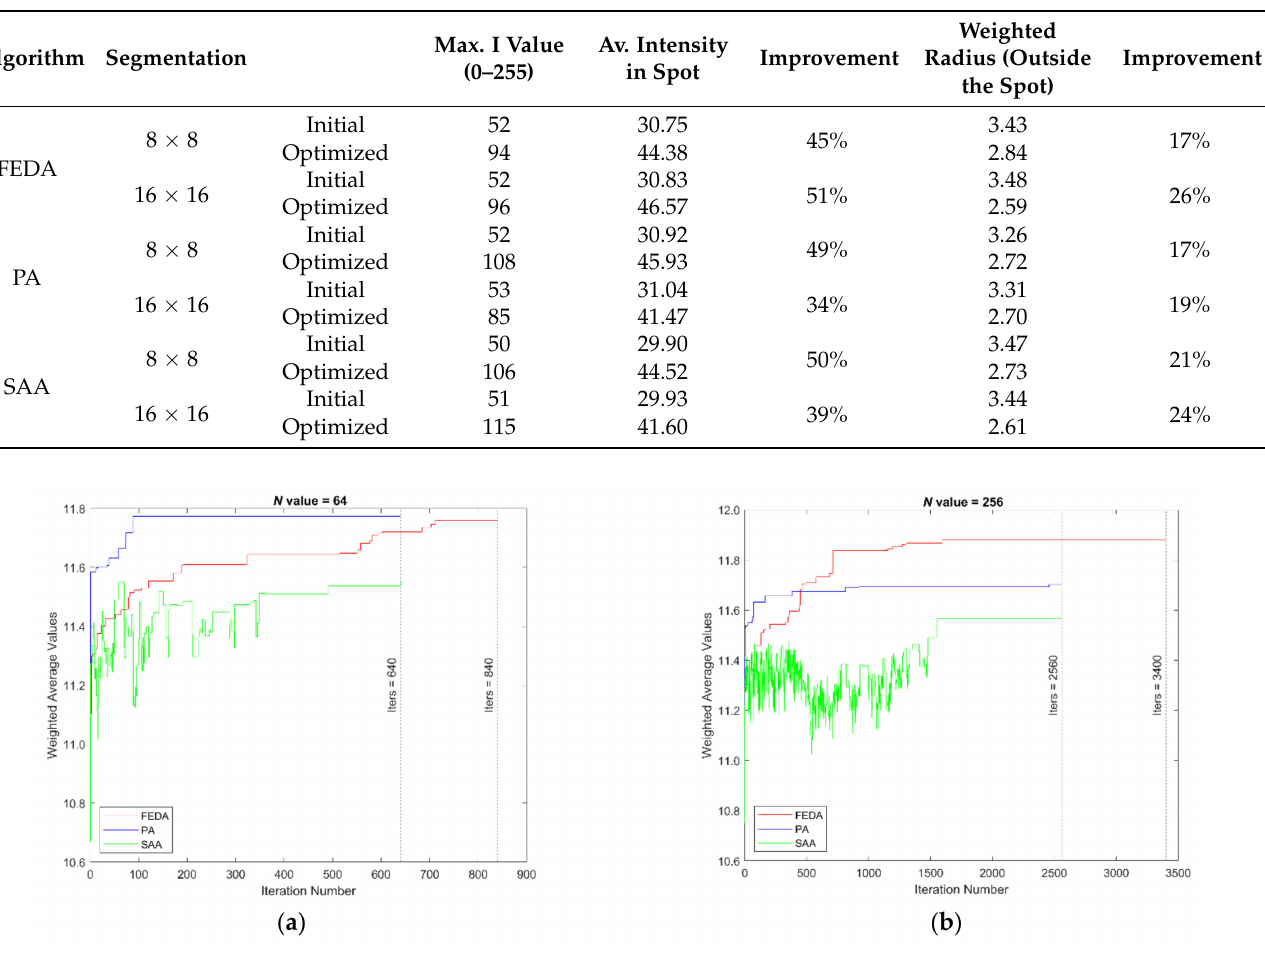
Figure 10. Convergence plots for the weighted average: ( a ) optimization with 8 × 8 segmentation; ( b ) optimization with 16 × 16